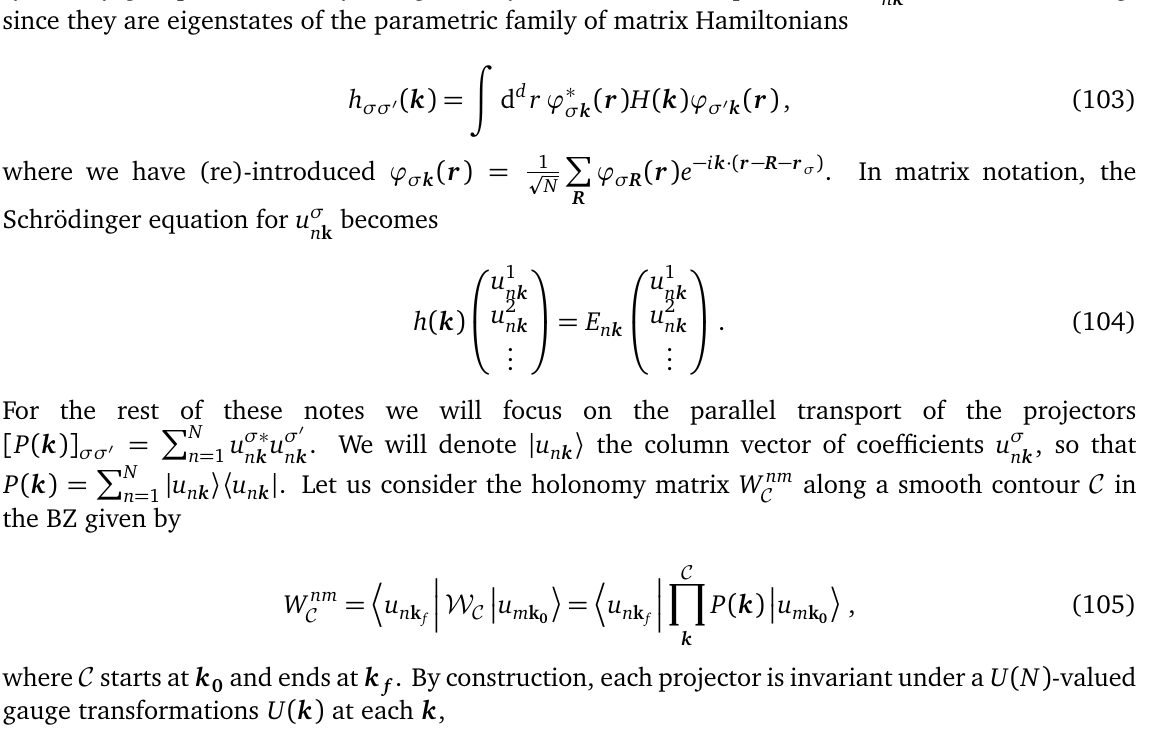
(cid:48) + g with basepoint k (cid:48) → k (cid:48) , and an alternative 0 0 0 0